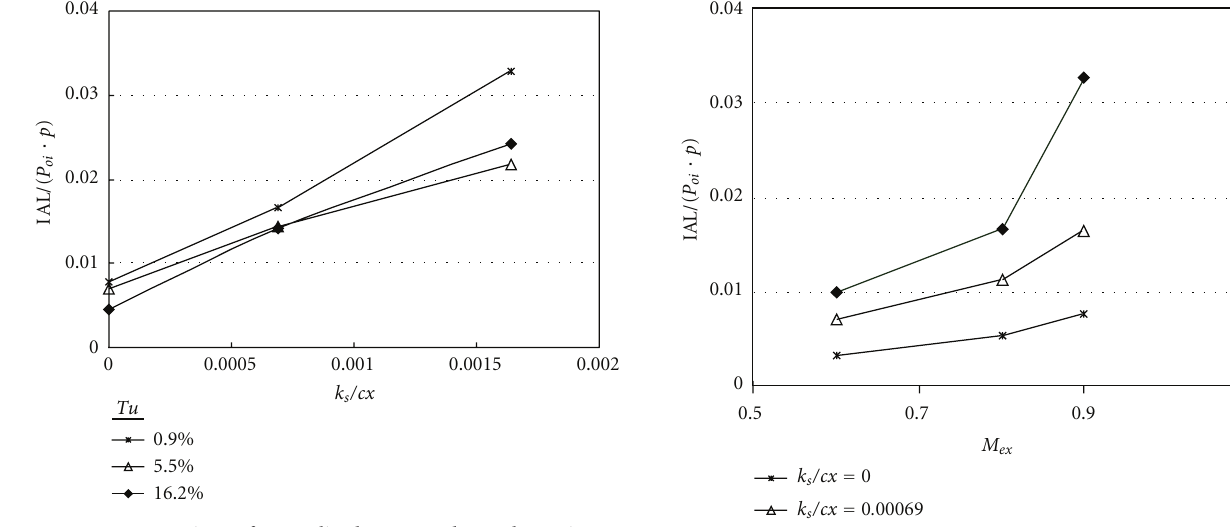
Figure 6: Comparison of normalized Integrated Aerodynamic Loss as dependent upon the normalized equivalent sandgrain roughness size for di ff erent inlet turbulence intensity levels for M e , ∞ = 0 . 9 for the symmetric airfoil investigations [8].